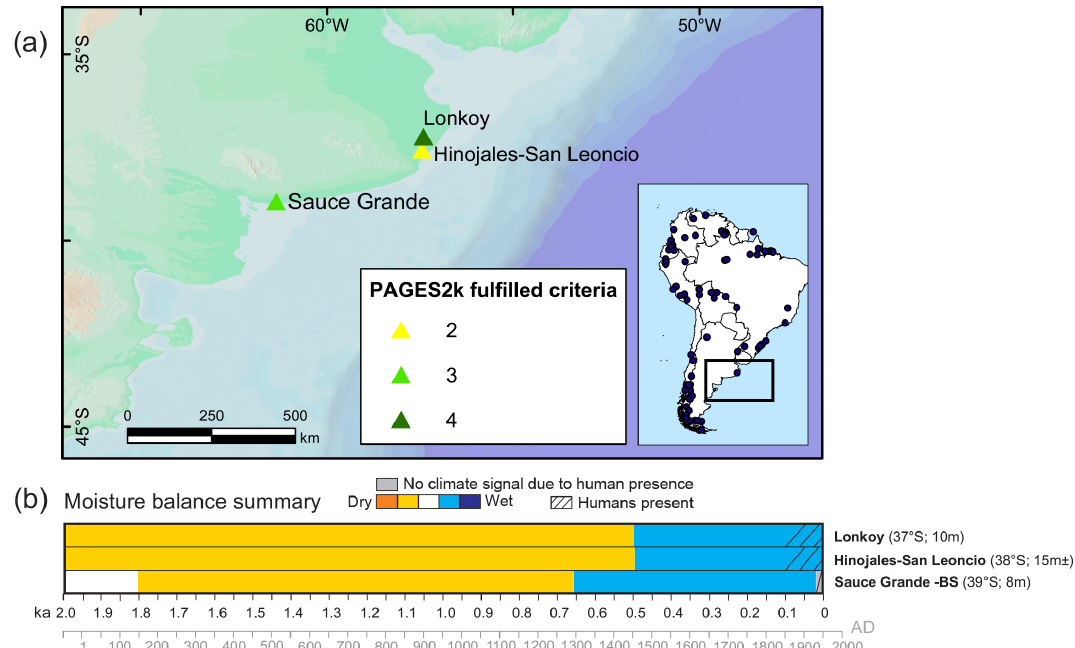
Figure 12. Panel (a) : map showing the pollen records discussed in the pampean plain and the number of PAGES-2k criteria these records fulfill. Panel (b) : summary of moisture balance and temperature including human interference for the pollen records discussed. Not all records are suitable to derive both a moisture and a temperature signal. Climate and human presence are shown overlapping when the pollen record is not conclusive regarding the derived signal. The section of the lower bar that is shaded grey indicates where the climate signal is obscured by human interference; m ± : ma.s.l. based on